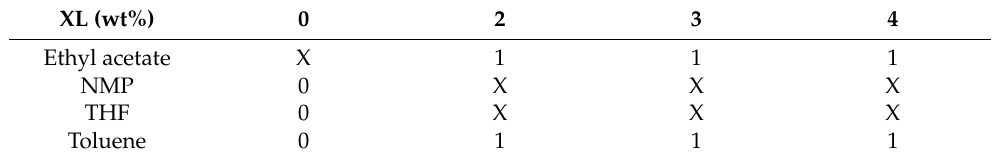
Figure 6. Water permeance and RB rejection of membranes consisting of 10 wt% ( a ), 12 wt% ( b ), and 14 wt% ( c ) PSf, 0.3 wt% PhIn, and varying cross-linker (XL) concentrations. Table 4. Qualitative observation of the solvent stability of UV-cured PSf supports consisting of 10, 12, or 14 wt% PSf, 0.3 wt% PhIn, and varying cross-linker concentrations.